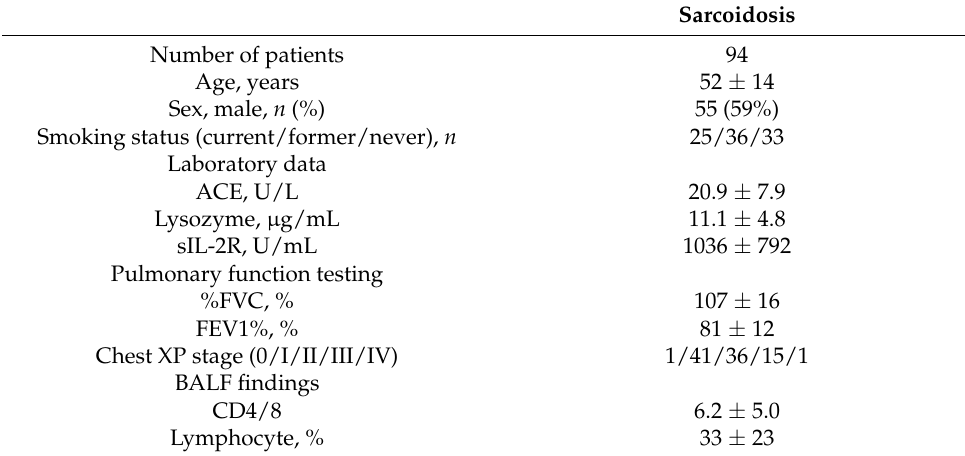
Table 1. Clinical profiles of sarcoidosis patients at diagnosis.